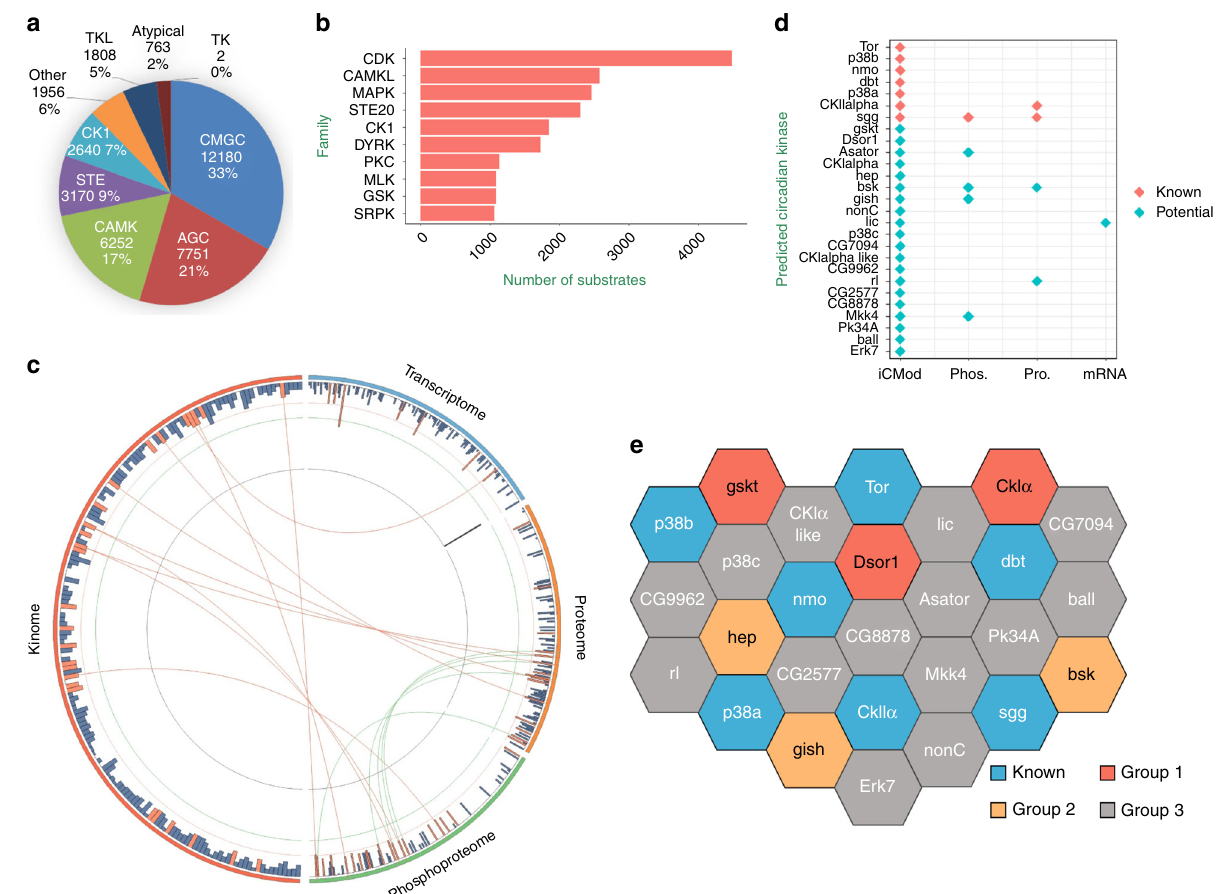
Fig. 4 Computational prediction of a circadian kinome. a The distribution of protein kinase groups predicted to phosphorylate NCPs. The top fi ve groups of kinases are CMGC (cyclin-dependent kinase [CDK], mitogen-activated protein kinase [MAPK], glycogen synthase kinase [GSK3], CDC-like kinase [CLK]), AGC (protein kinase A, G, and C), CAMK (calcium/calmodulin-dependent protein kinase), STE (Ste20 kinase), and CK1 (casein kinase I). b The top 10 kinase families predicted to phosphorylate NCPs. c Each one of the four parts of the circle includes all 169 kinases that can be predicted by GPS 2.1. Each bar indicates a kinase. Kinases that oscillate at mRNA, protein or phosphorylation level are indicated in orange. Predicted circadian kinases are also indicated in orange. Among the kinases labeled in orange, the same kinase is connected by a line. d 27 potential circadian kinases predicted by iCMod, including seven that are already known to regulate the clock (red) and 20 that potentially participate in circadian regulation (green). Predicted circadian kinases that oscillate at mRNA, protein, or phosphorylation level are indicated. e Seven kinases previously known to regulate the clock are labeled in blue. Three kinases are found to be involved in modulating locomotor rhythm (labeled in red), and three more are found to be potentially involved (labeled in orange). The remaining 14 predicted circadian kinases are labeled in